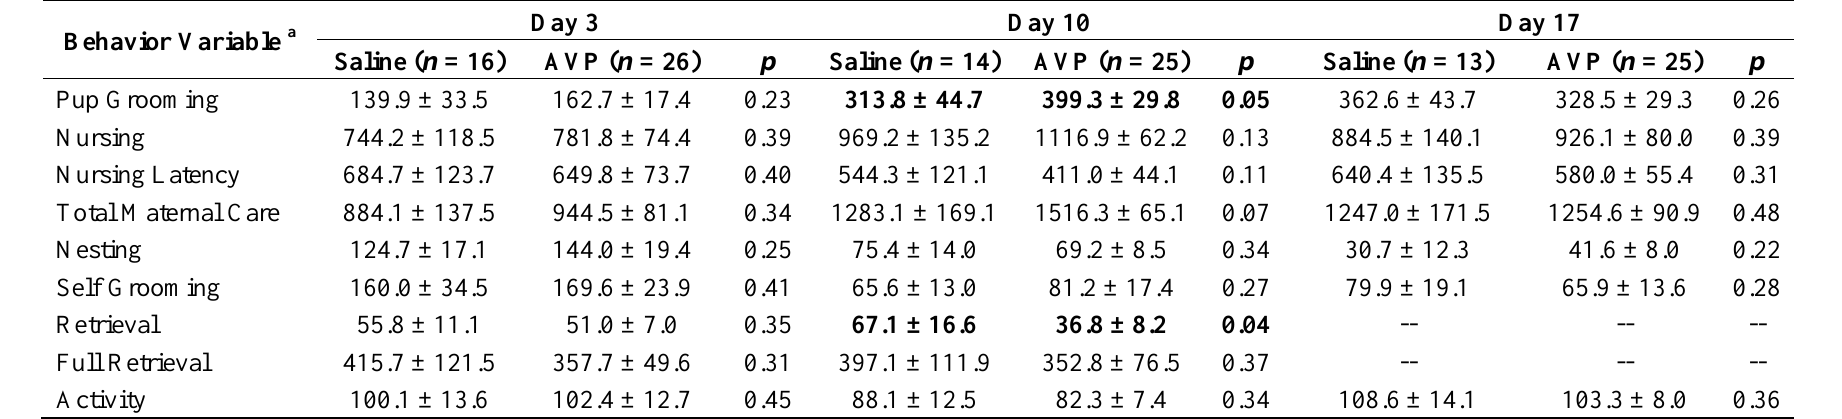
Table 1. Means ± SEM behavioral data during 30-min maternal care tests on lactation days 3, 10 and 17. Retrieval data were not collected on day 17 as pups were often active and moving about the cage. Data in bold represent significant differences between saline and AVP treated